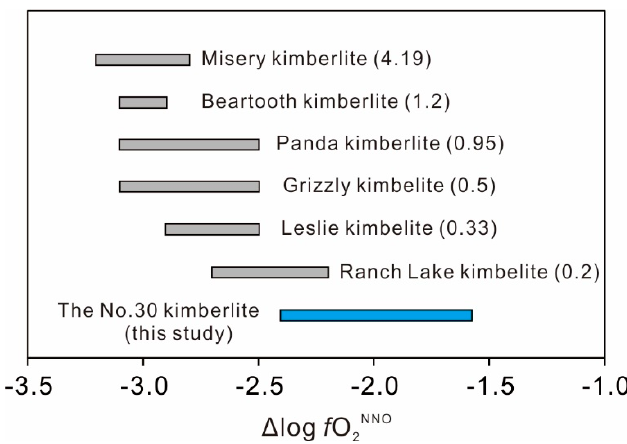
Figure 6. Estimated log f O 2 oxygen fugacity conditions ( ∆ NNO; derived from Ol–Sp thermobarometry at an assumed pressure of 1 GPa) for the No.30 kimberlite (this study) compared with Misery, Beartooth, Panda, Grizzly, Leslie, and Ranch Lake kimberlites from the Lac de Gras area [17] (the numbers in parentheses represent diamond grades of kimberlites in units of carats/ton).